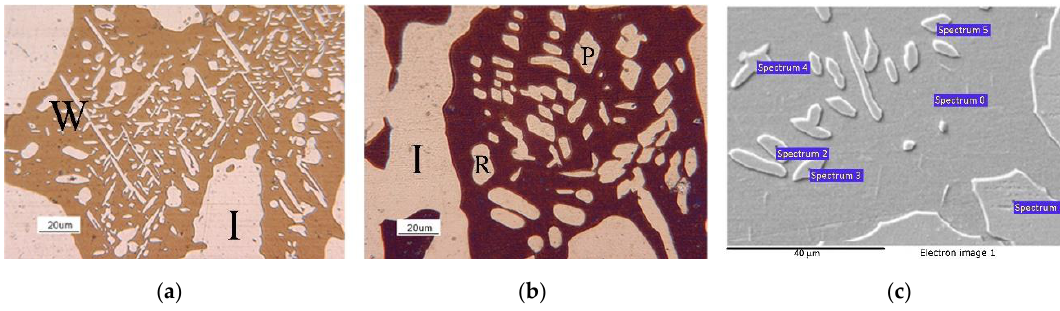
Figure 2. Microstrcture of F1/2 ( a ), F1 ( b ), and scanning electron microscopy (SEM) caption on sample F1/2 for EDS analyses ( c ). Particulars of the DSS microstructure with varying austenite shapes, it is possible to distinguish the following: austenitic islands (I), Widmanstetten arms (W), and ( b ) polygonal (P) and round-shape grains (R).